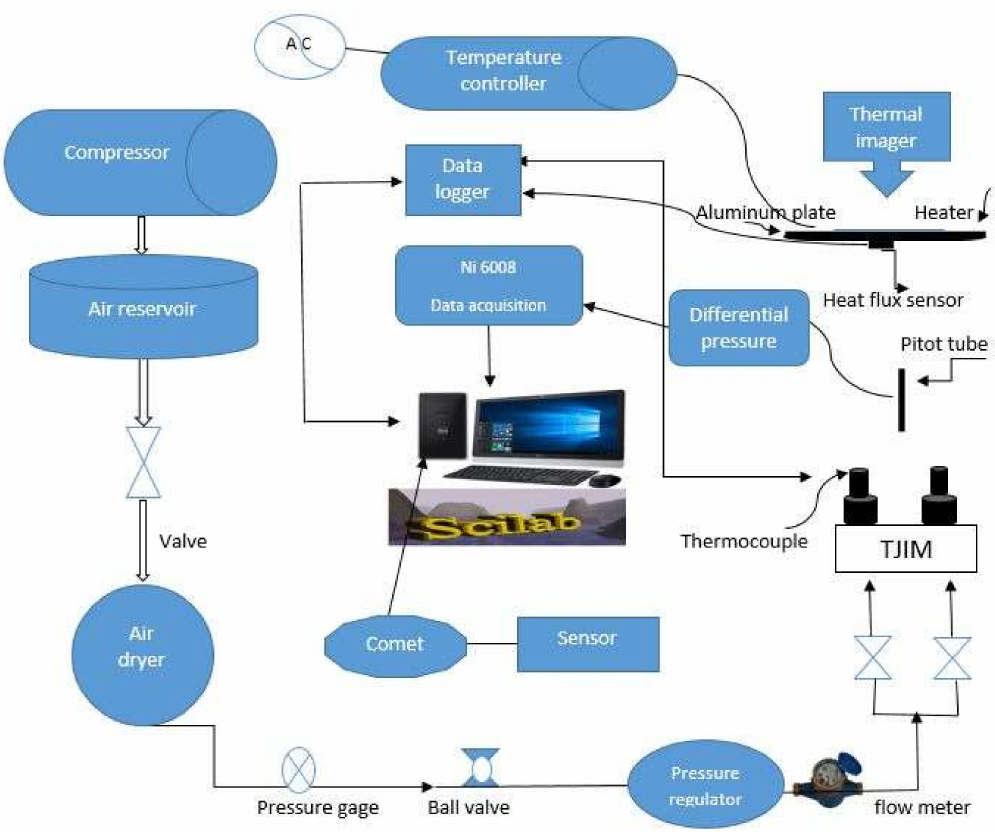
Figure 3. A schematic diagram of the thermal imaging setup and heat-transfer experiment for twin jets impingement.